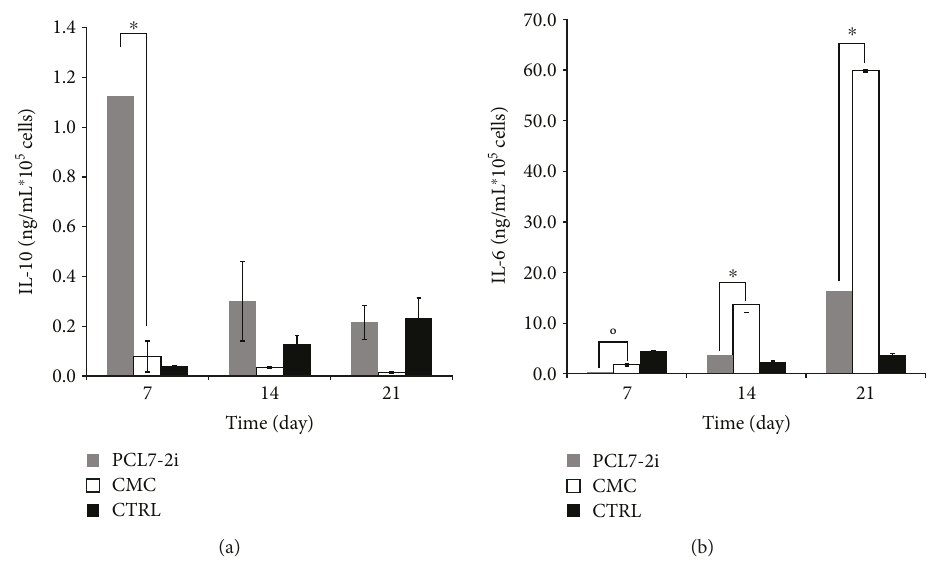
Figure 5: Interleukin-10 (a) and 6 (b) trend in PCL7-2i and control samples. ∗ p < 0 0001 and ° p = 0 0002 .